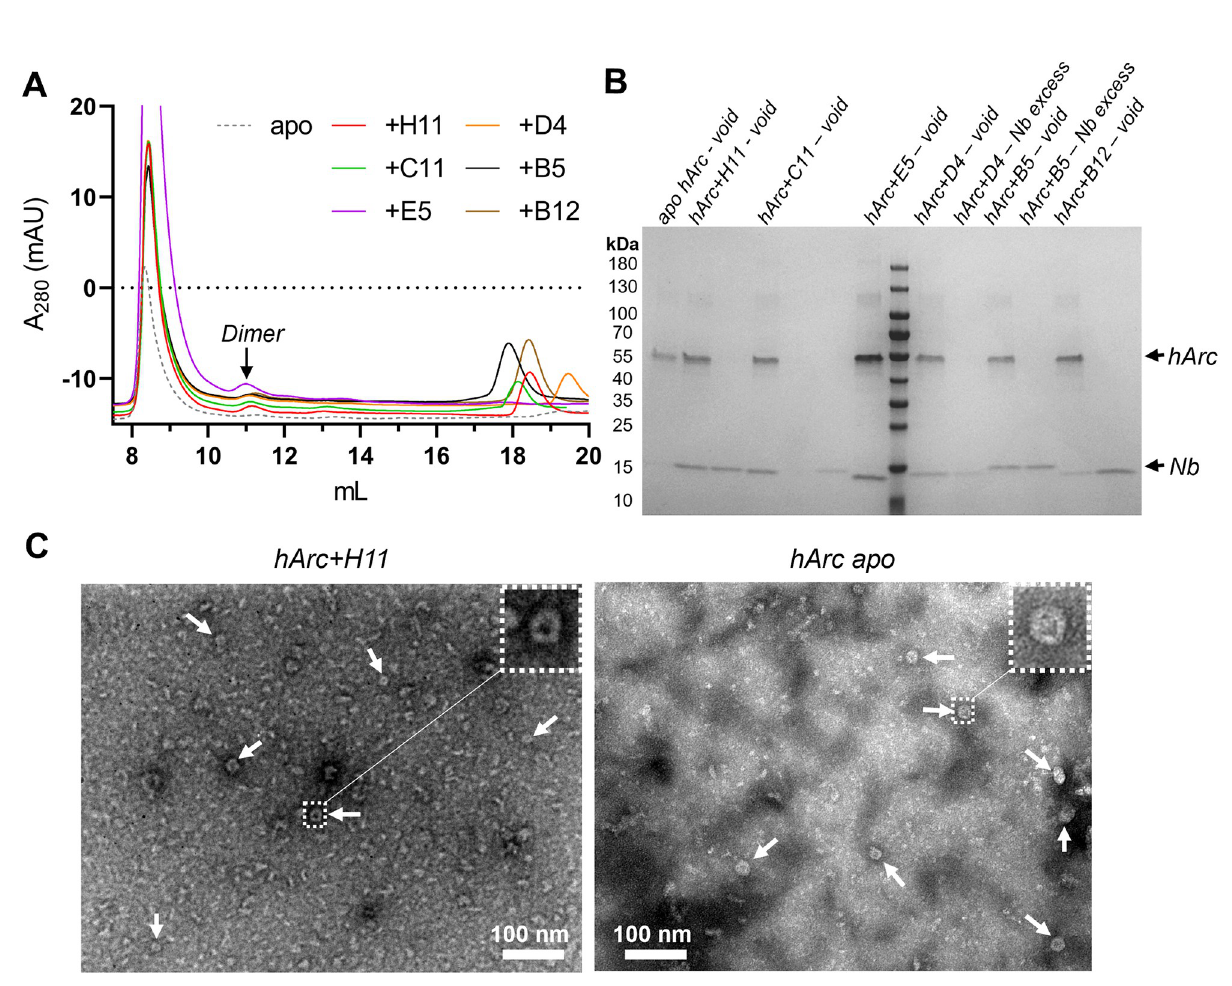
Fig 6. Rudimental analysis of Nb association with hArc capsid fraction. A Analytical SEC of capsid hArc-Nb complexes. 2 nmol of Arc capsids were mixed with a 1.5-fold molar excess of Nbs and run on a Superdex 200 Increase 10/300 GL in PBS buffer. Noted is the presumably dimeric peak present in some Nb complexes, with an elution volume corresponding to that of the FLrArc-7A complexes. NbArc-E5 was accidentally mixed with 4 nmol of hArc, resulting in the large void peak and lack of Nb excess peak. B SDS-PAGE analysis of SEC fractions, demonstrating that Nbs co-elute with the capsids. C Negative staining TEM images of capsid hArc at 150,000x magnification with NbArc-H11 (left) and without Nb (right). Arrows point at capsids, and a magnified view of selected capsids is shown.